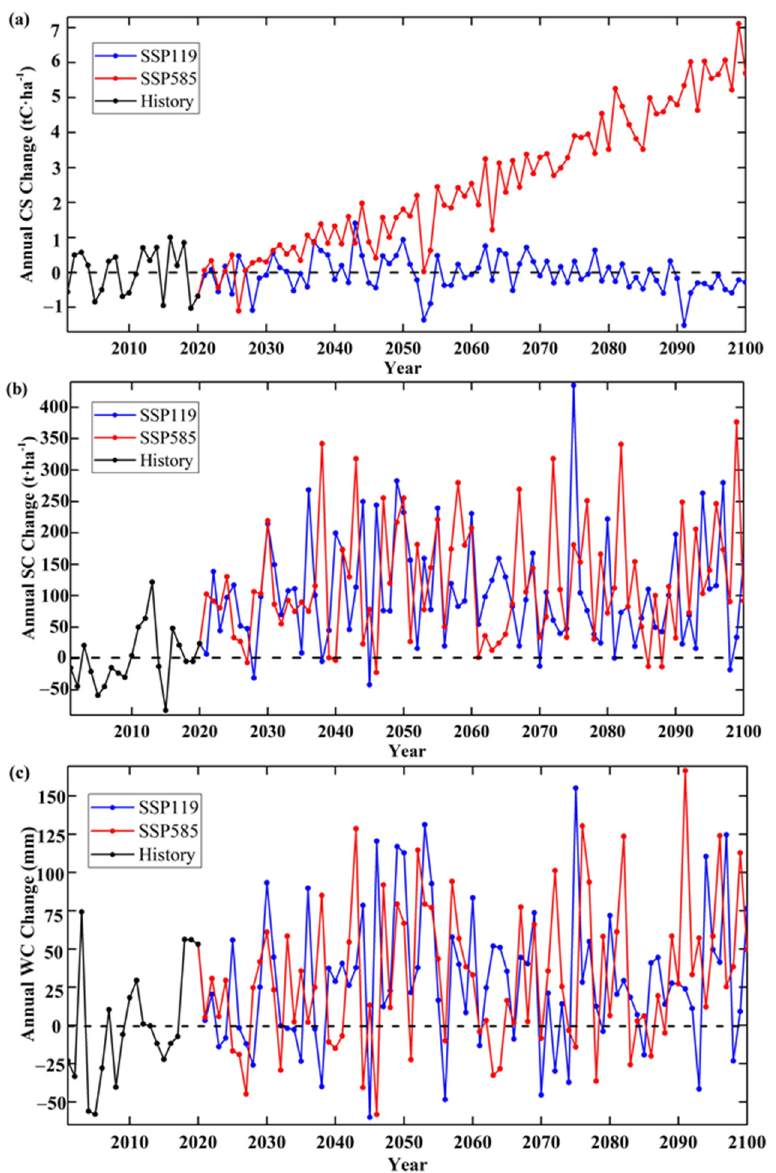
Figure 4. Change in the annual ecological functions of the Loess Plateau from 2001–2020 to 2021–2100. ( a ) Carbon stock function, CS; ( b ) soil conservation function, SC; and ( c ) water conservation function, WC.